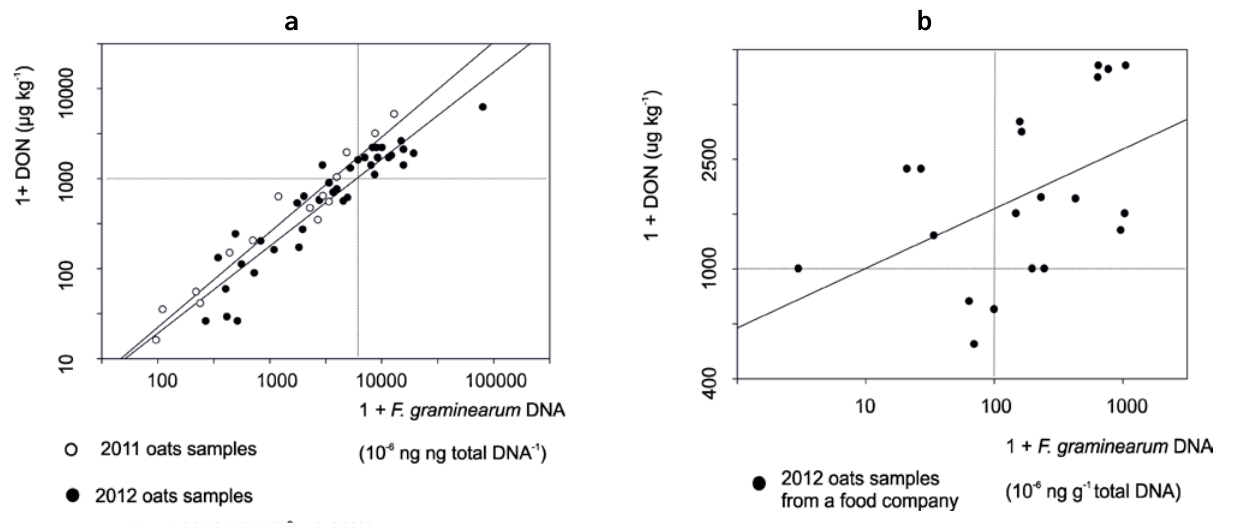
Figure 2. Correlation between log F. graminearum DNA and deoxynivalenol (DON)